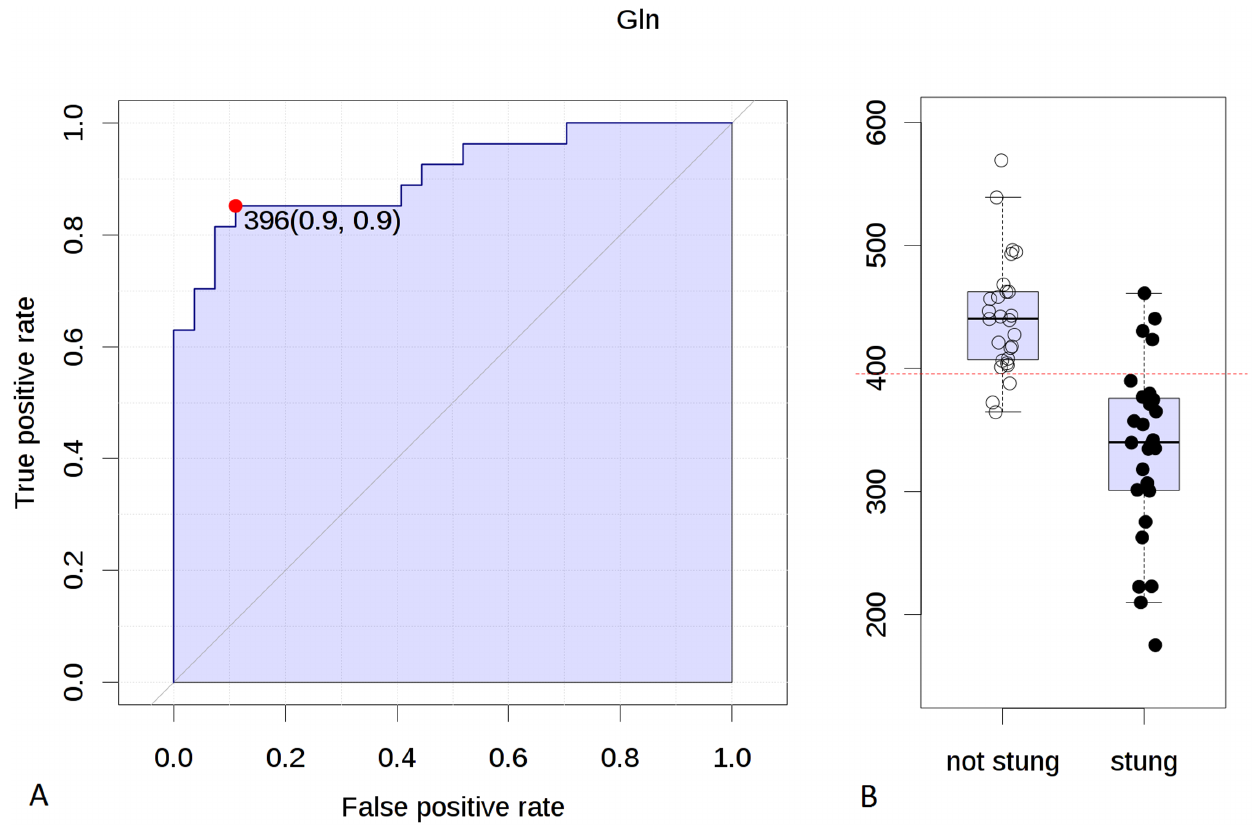
Figure 5. A: Receiver operating characteristic (ROC) curve for Gln. Cut-off value: 396.0 m M/l. Specificity: 90%, sensitivity: 90%. Area under the curve (AUC): 0.912, confidence interval: 95% (0.816–0.979); B: Concentration of Gln in two groups of beekeepers (directly after a sting and at least six weeks since the last sting). Dotted line indicates a cut-off value of 396.0 m M/l.